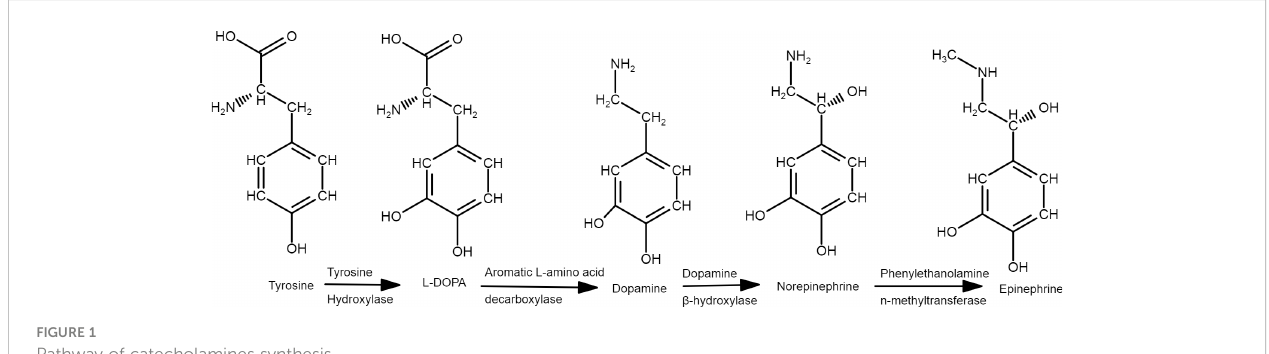
FIGURE 1 Pathway of catecholamines